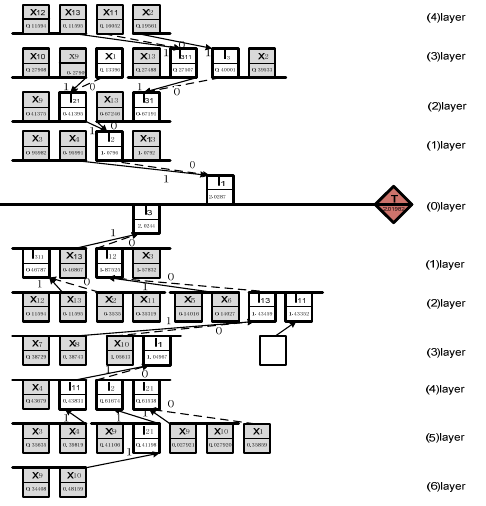
Fig. 8 Incident tree model of vehicle leave roadway